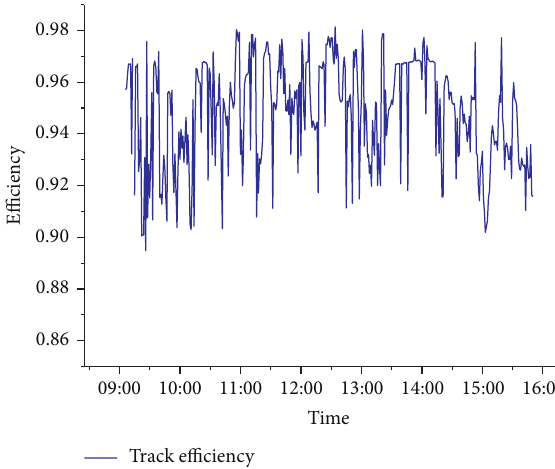
Figure 12: MPPT controller’s tracking efficiency under rapidly changed solar strength.